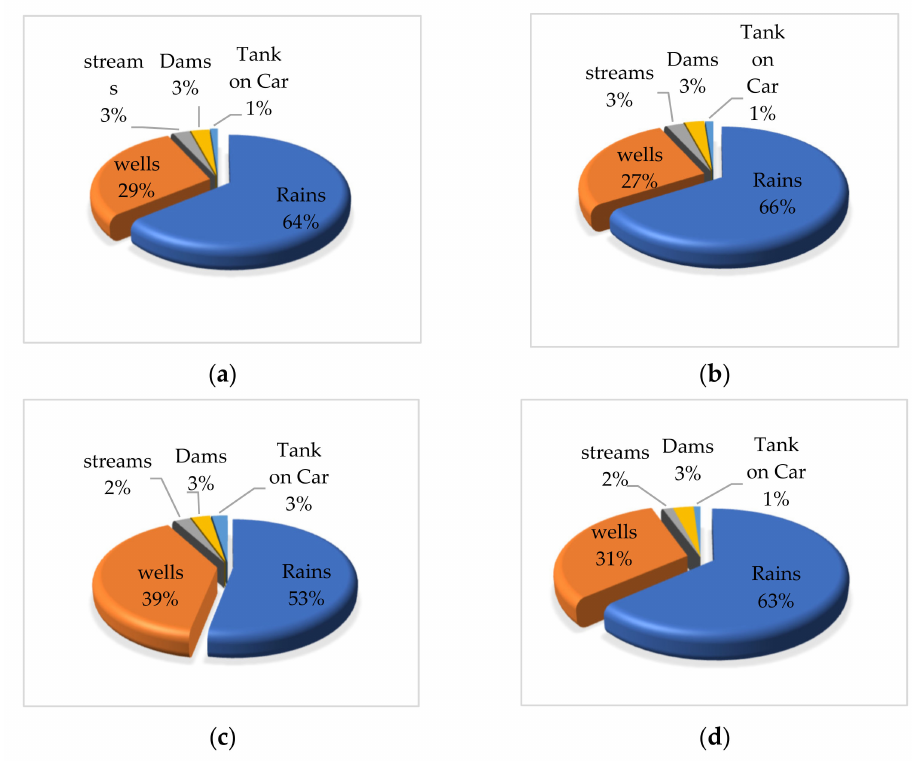
Figure 10. Sources irrigation for a cropped area in Sana’a region: ( a ) 2011; ( b ) 2013; ( c ) 2015; ( d ) 2018.